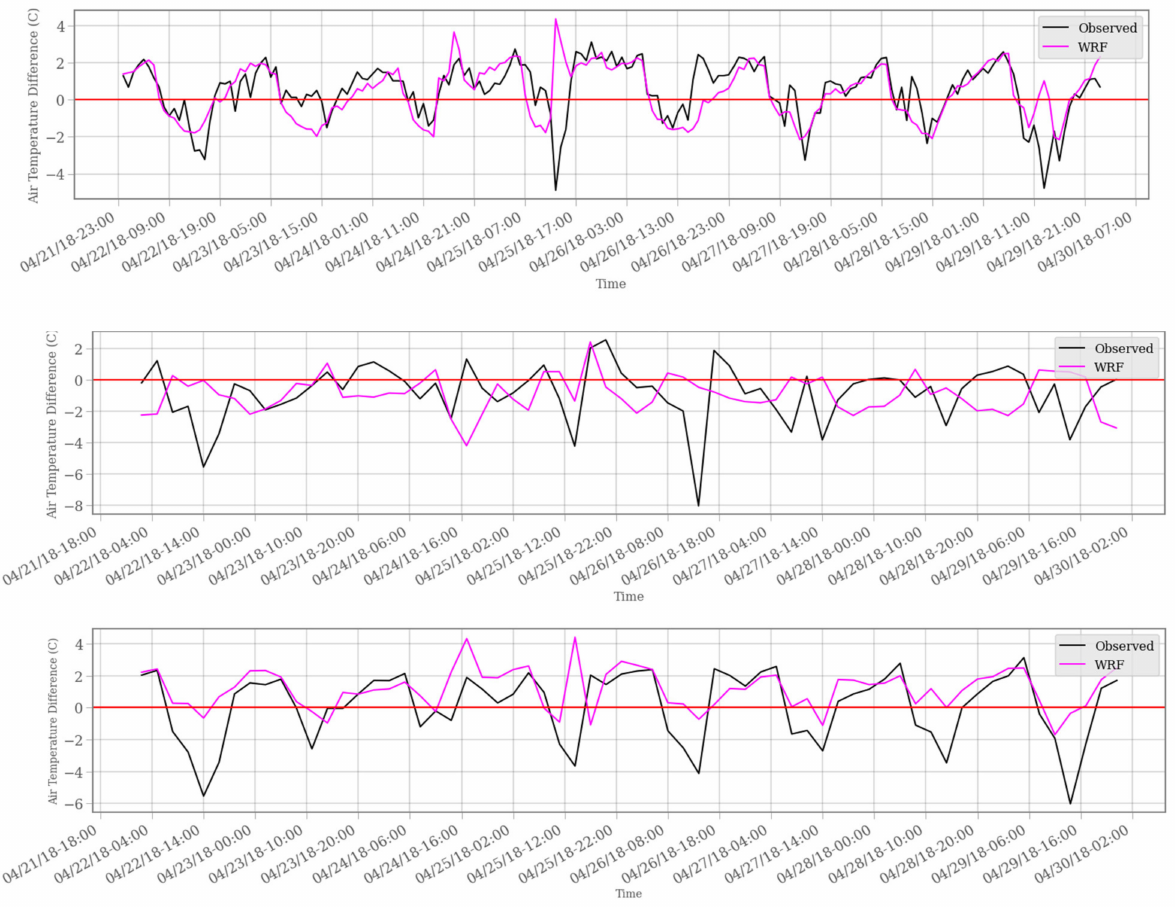
Figure 4. Temporal evolution of urban heat island intensity of observed and WRF simulation for NAIA ( top ), SGQ ( center ), and Manila Port ( bottom ). Positive values indicate higher urban temperature while negative values indicate higher rural